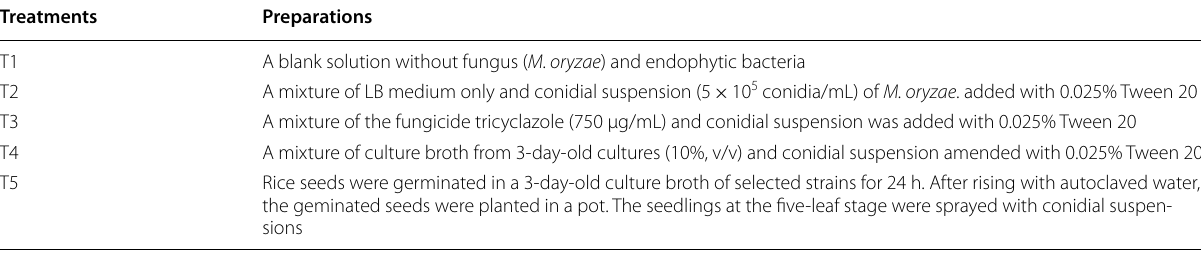
Each treatment included three pots (20